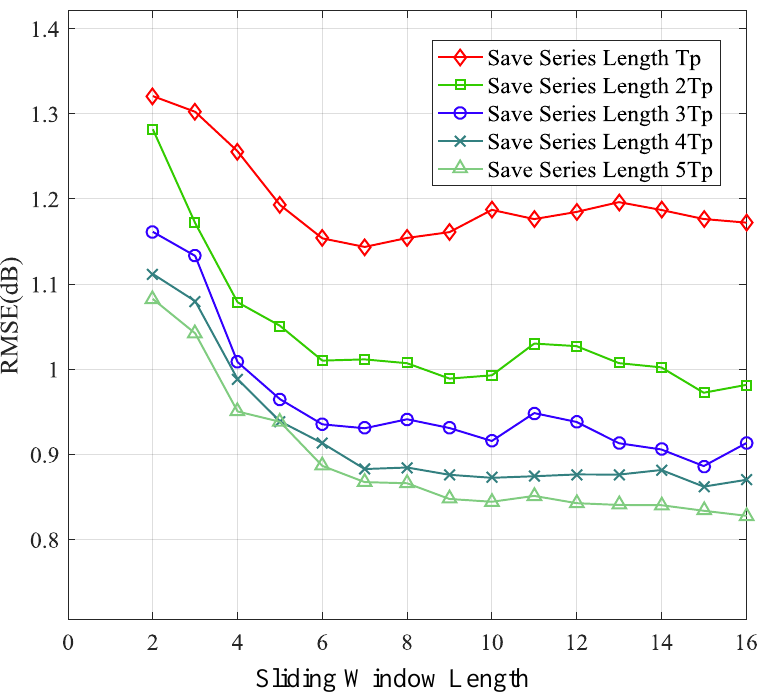
Figure 17. RMSE of 25-step ahead prediction with different length of sliding window and stored